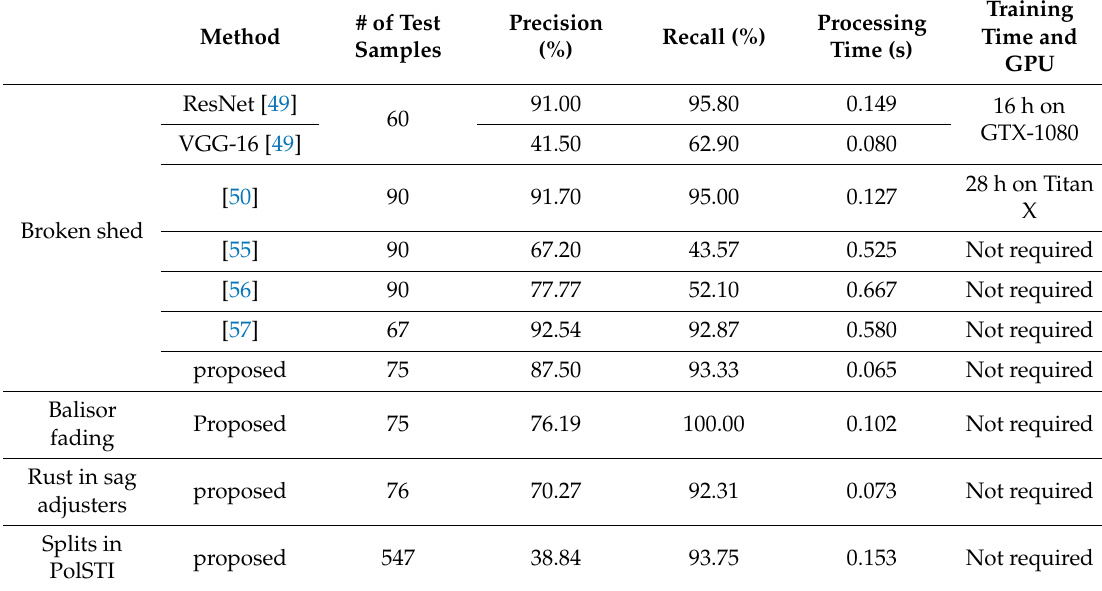
Table 4. Summary of the performance of the defect detection